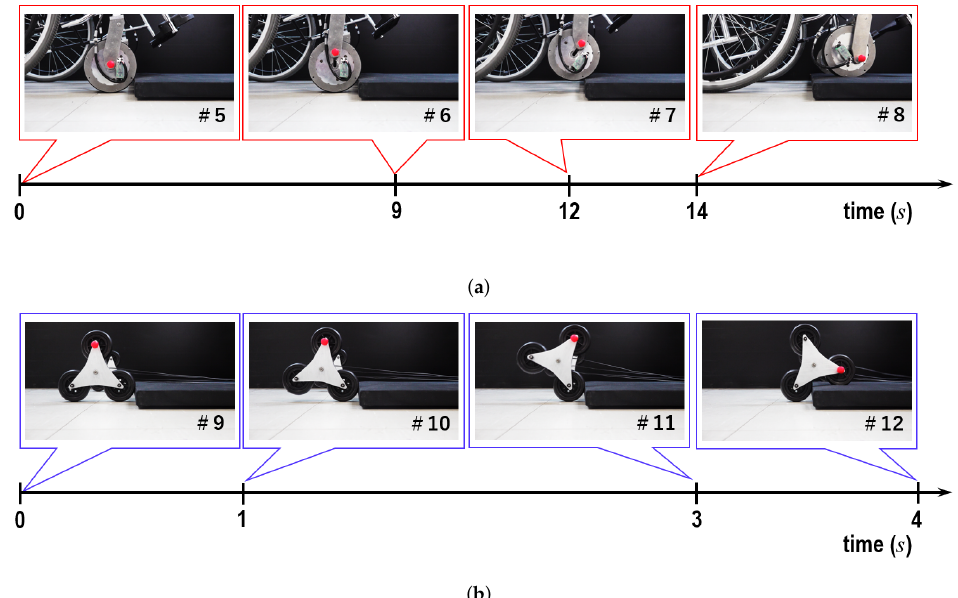
Figure 17. Experimental scenes for comparison analyses where the horizontal direction indicates time over the step-ascending motion according to different wheel types. ( a ) Case-2: wheel with vertically translated axle; ( b ) case-5: three-wheel